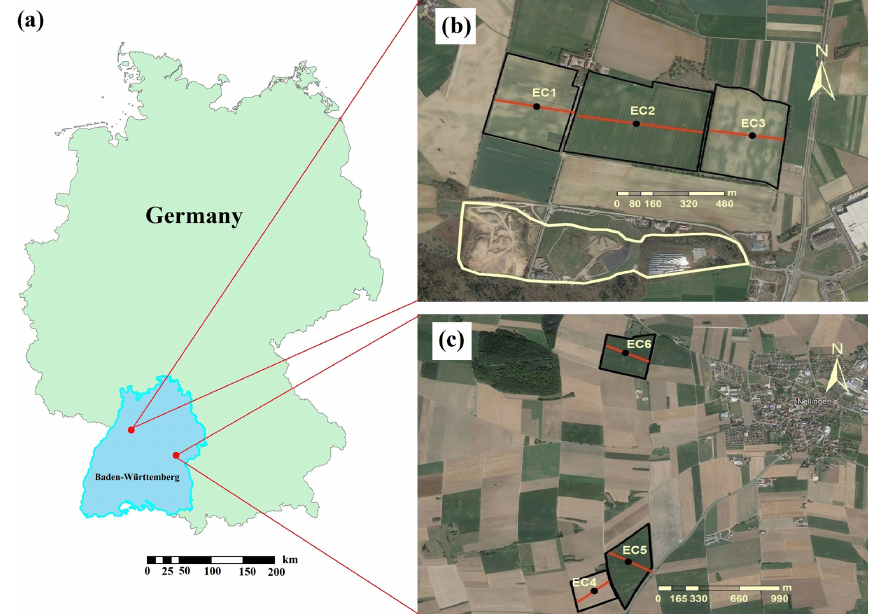
Figure 1. (a) Geographical overview (a) and locations of the study sites and EC stations in Kraichgau (b) and Swabian Jura (c) (Google Earth; KR on 31 March 2017 and SJ on 26 August 2016). Red transect lines indicate positions of conducted micro-topographic measurements along the prevailing wind directions. The yellow line demarks the boundaries of a former landfill site (b)